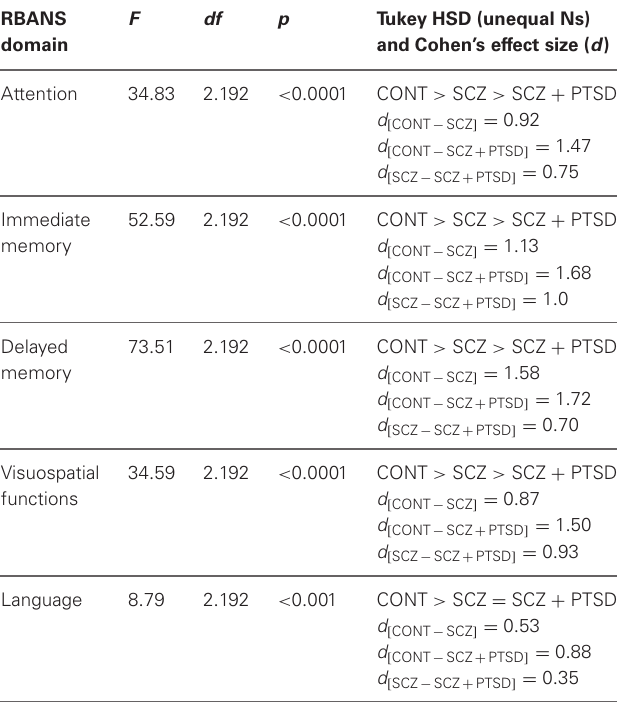
Table 2 | Neuropsychological